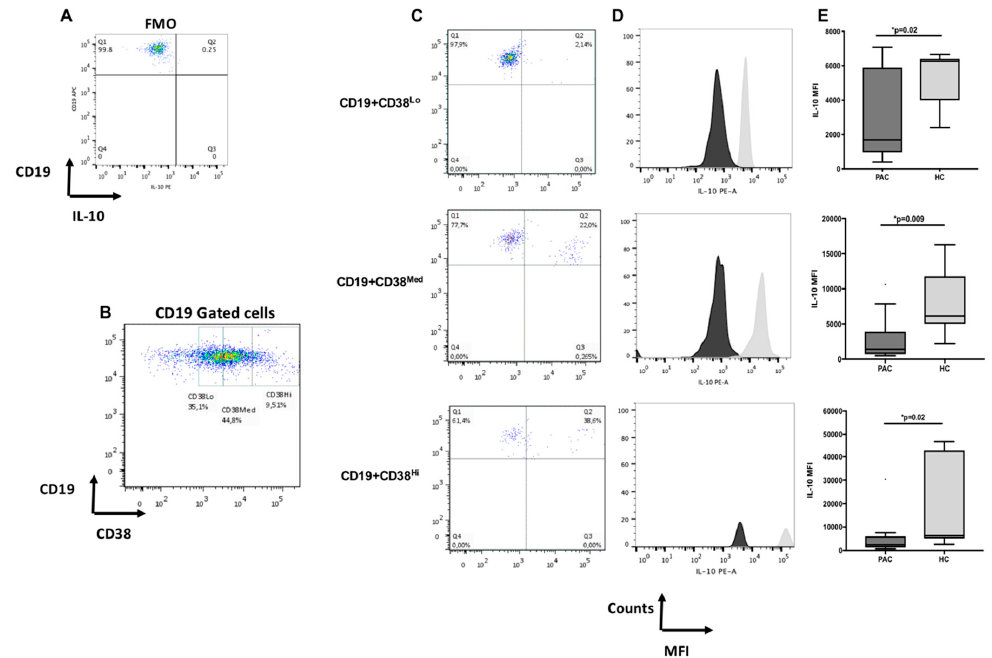
Figure 2. Expression of IL-10 in CD19 + CD38 cell subsets in patients with perennial allergic conjunctivitis ( PAC ) and healthy controls (HC). Representative dot plots from gates performed according to the CD38 expression on B cells (see Figure S1 to consult the hierarchical analysis performed). Fluorescence minus one (FMO) ( A ); CD38 Lo/Med/Hi on gated CD19 + cells ( B ). Representative dot plots of CD19 + CD38 Lo/Med/Hi vs. IL-10 staining ( C ); median fluorescence expression (MFI) of IL-10 on gated CD19 + CD38 + Lo/Med/Hi cells ( D ). The dark-grey histogram corresponds to PAC patients; the light-grey histogram corresponds to healthy controls; ( E ) column shows the IL-10 MFI comparison between the two groups. See Figure S2 for cytometric control of the IL-10 analysis. Data are expressed as the mean ± standard deviation (SD). Statistical differences were considered when p < 0.05. The black dot above PAC columns corresponded to the outlier values.